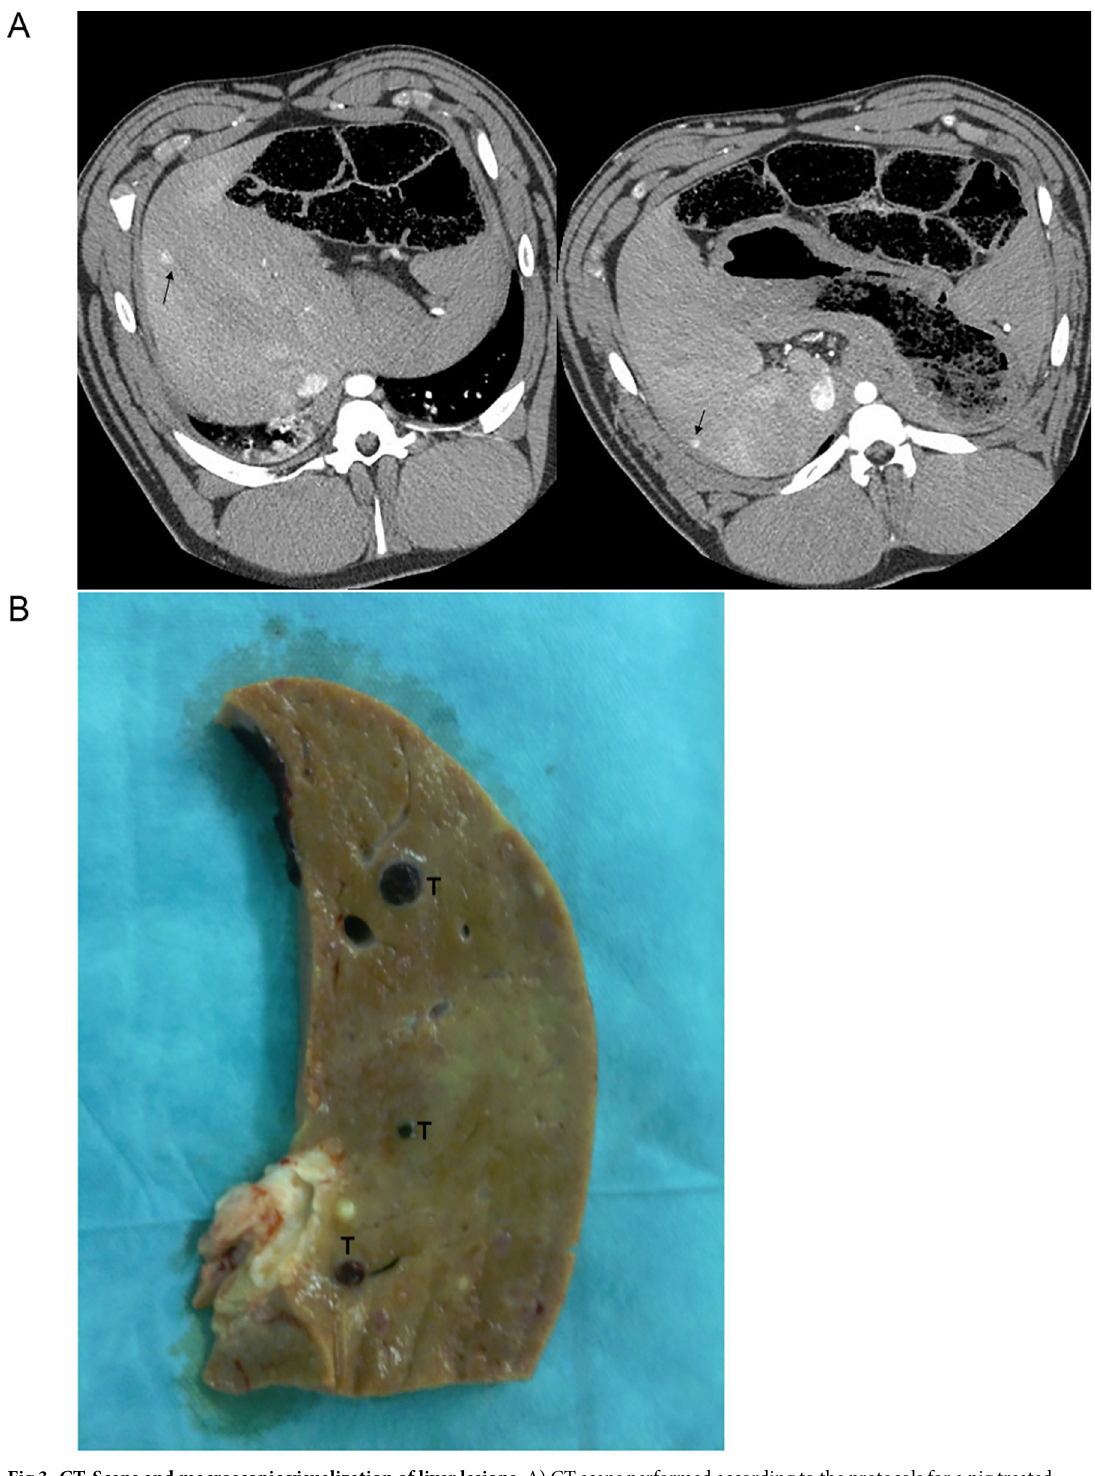
Fig 3. CT-Scans and macroscopic visualization of liver lesions. A) CT scans performed according to the protocols for a pig treated with 15 mg/kg DENA for 90 days. Arrows indicate radiologically verified liver tumor in the pig liver. B) Macroscopic picture from a transverse liver section of a pig treated with 15 mg/kg DENA. Tumor lesions (T) of different colors and sizes are indicated.